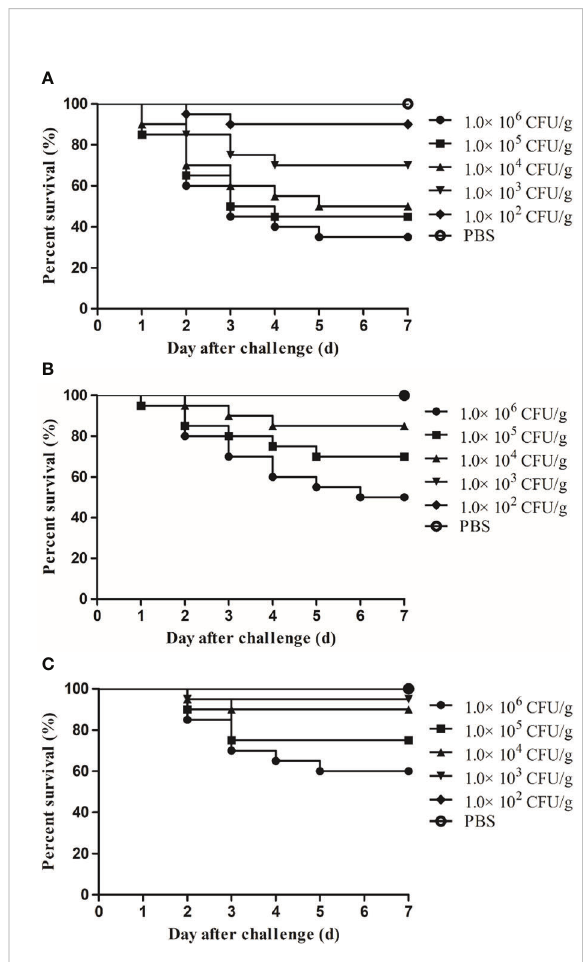
FIGURE 4 Survival rates of largemouth bass challenged by various doses of